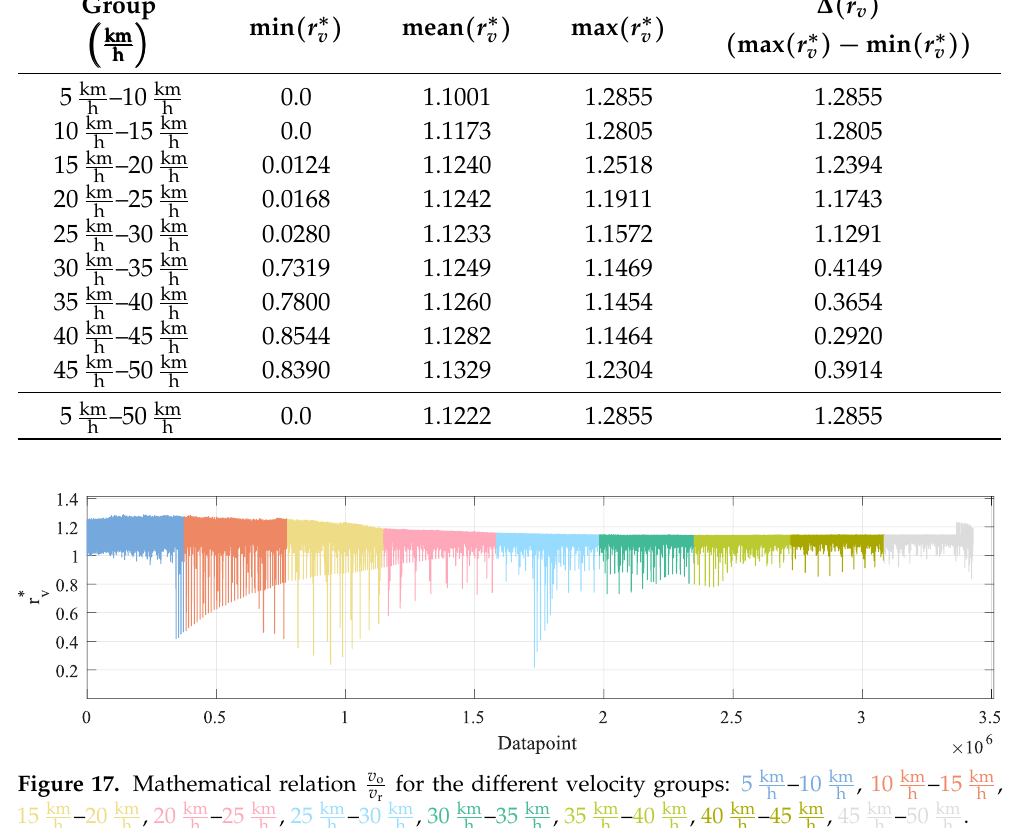
Table 11. Relation r ∗ v according to Equation (27). # of measurements: 3,428,099.